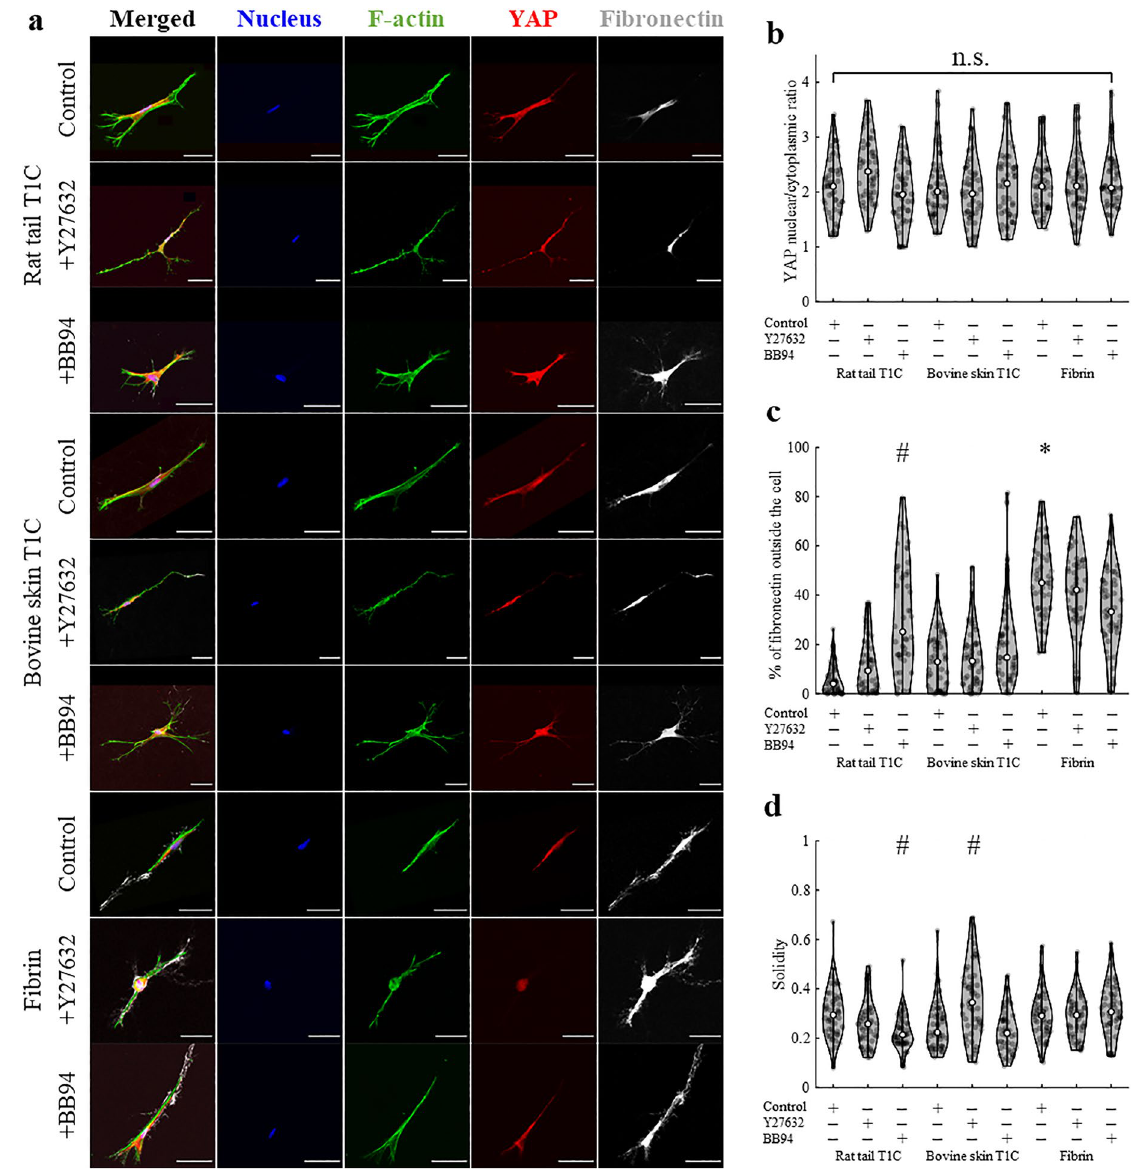
Figure 3. The effect of ECM type and treatment on nuclear/cytoplasmic YAP ratio, fibronectin secretion and solidity of DFs. ( a ) Immunofluorescent confocal images of DFs ( n sample = 3, n cells = 50 per condition). Scale bar = 50 μm. Quantification of ( b ) nuclear/cytoplasmic YAP ratio, ( c ) fibronectin secretion, described as % of fibronectin signal found outside of the cell and ( d ) cell solidity. Statistical difference across tested ECM types (as compared to rat tail T1C) or following Y27632 or BB94 (as compared to control condition) is denoted by * or #, respectively. Detailed statistical comparison between the groups for ( b – d ) is shown in Table